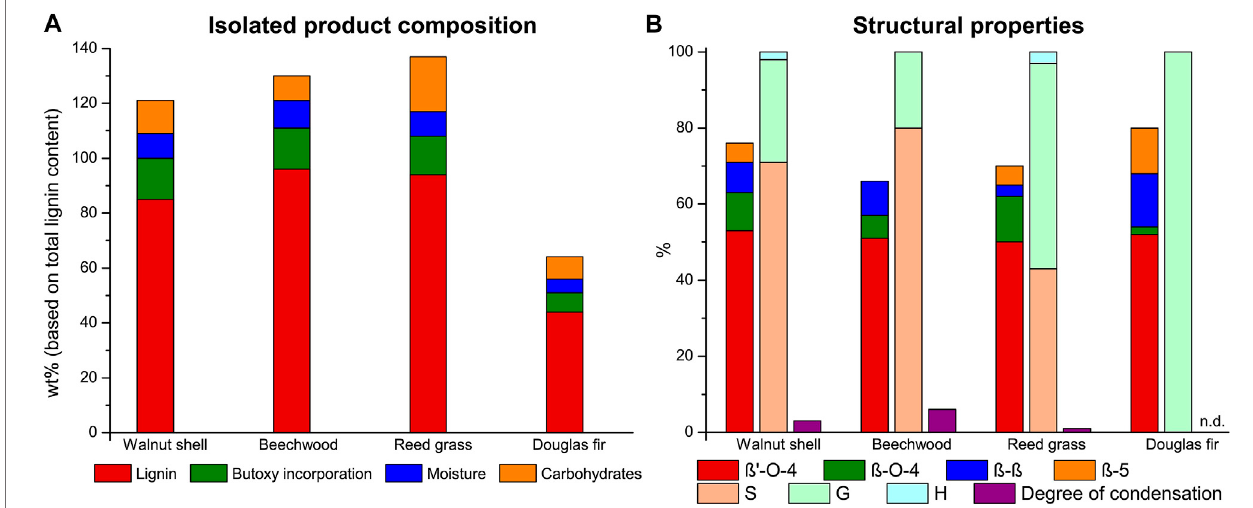
FIGURE 3 | Lignin extraction ef fi ciency with product composition with each component expressed as a percentage of the total lignin content (A) and the linkage content (per 100 C9 units), S/G/H ratio and the degree of condensation (based on condensed S-units) of the isolated butanosolv lignin (B) obtained with the optimized extraction conditions (9:1 n-butanol/water, 0.18 M H 2 SO 4 ) on different feedstocks.